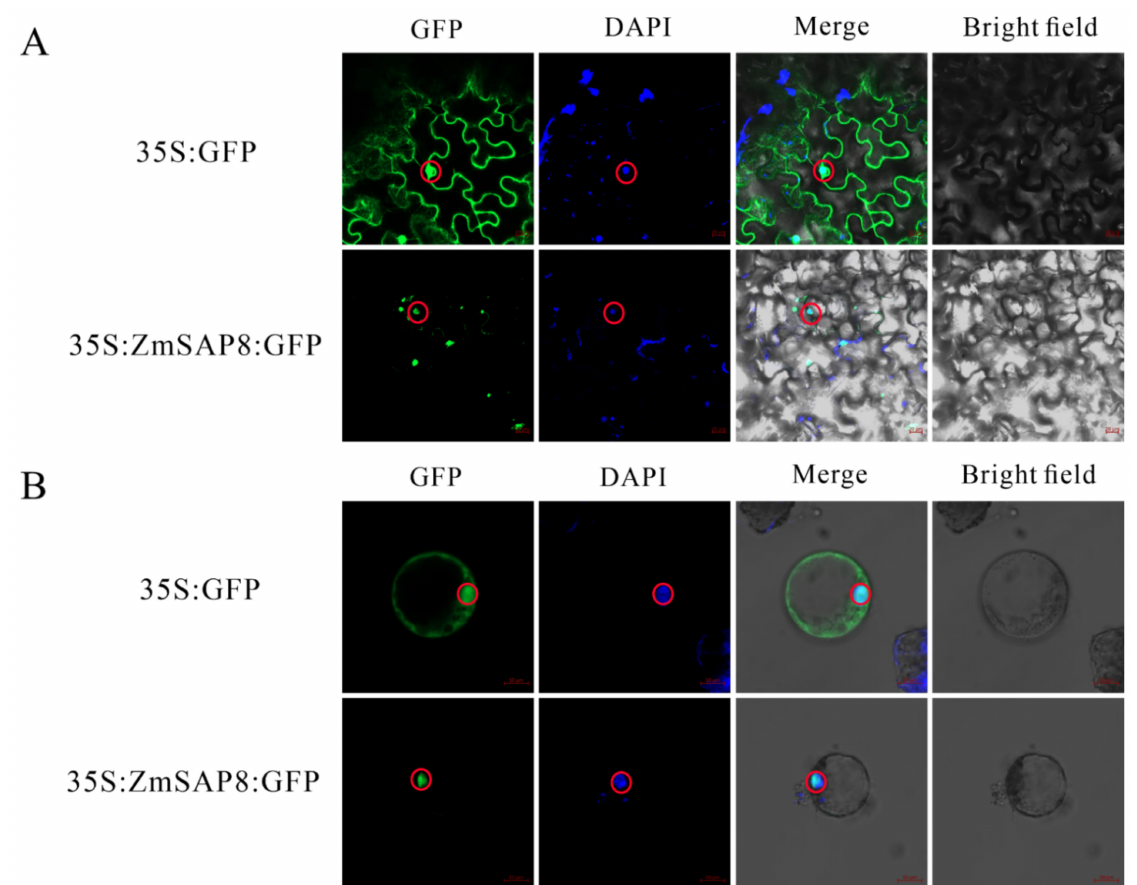
Figure 10. Subcellular localization of ZmSAP8. ( A )The leaves of Nicotiana benthamiana were trans- formed with constructs harboring 35S:ZmSAP8-GFP fusion proteins via agrobacterium-mediated infiltration. The 35S::GFP empty vector was used as a positive control. Scale bar = 20 µ m. ( B ) The pro- toplasts of maize were transformed with plasmid pCAMBIA1305 construct harboring 35S:ZmSAP8- GFP fusion proteins by PEG-mediated transformation. The 35S:GFP empty vector was used as a positive control. The nuclei in which the GFP signal and DAPI signals really overlapped are indicated with red circles. Scale bar = 10 µ m.